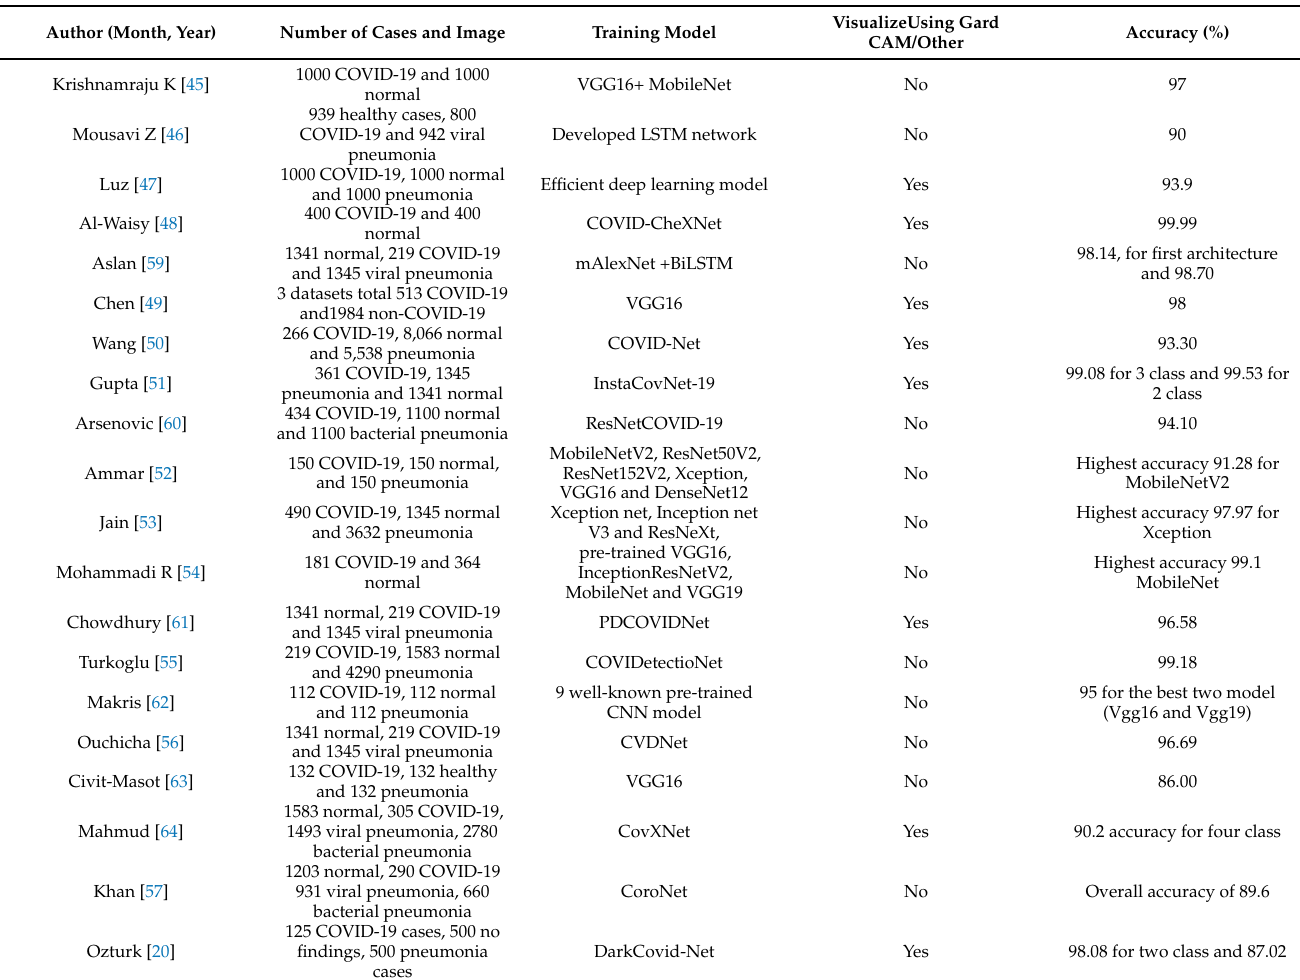
Table 1. Related literature on X-ray for the purpose of COVID-19